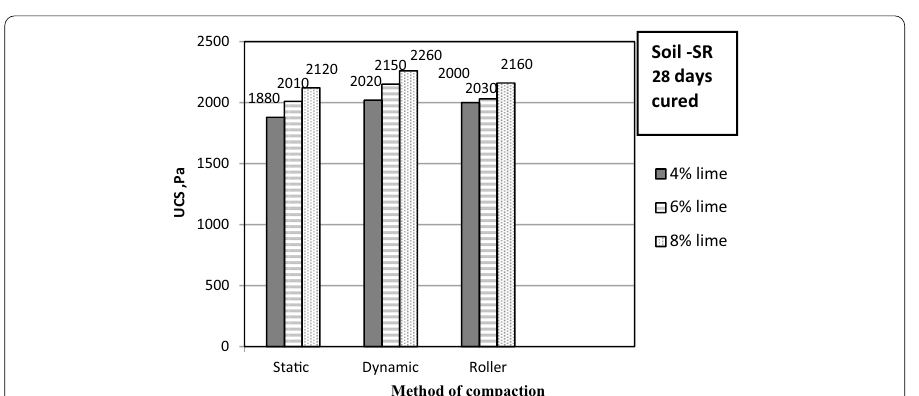
Fig. 10 Effect of methods of compaction on UCS of soil SR treated by lime cured for 28